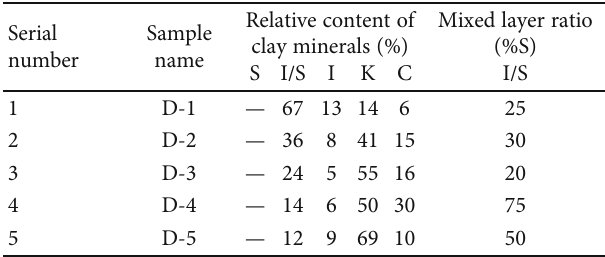
Table 2: Clay mineral